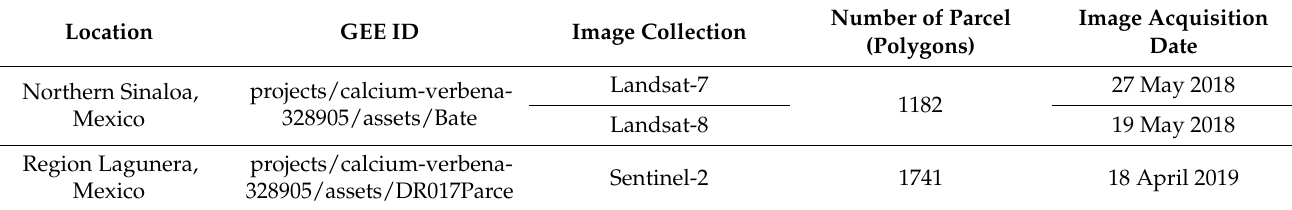
Figure 3. Location of the agricultural areas for the performance evaluation of VICAL: ( a ) irrigation “Modulo Batequis” in irrigation district 075 “Valle del Fuerte”, northern Sinaloa; ( b ) irrigation “Modulo El Porvenir” in irrigation district 017 “Region Lagunera”, Mexico. Table 7. Details of study areas and satellite images for the performance evaluation of